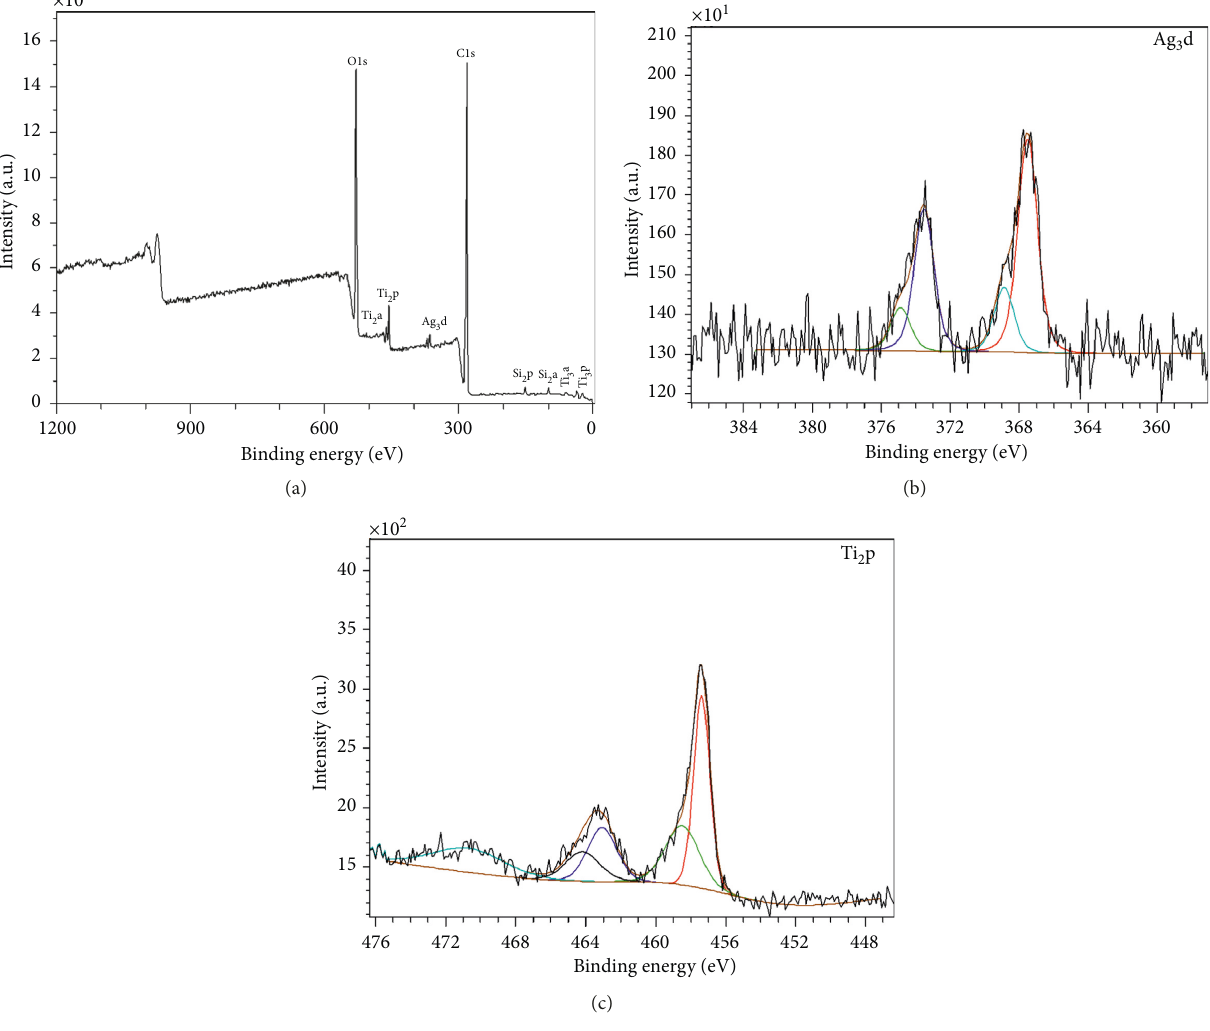
2 , (b) Ag 3 d, and (c) Ti 2 p.